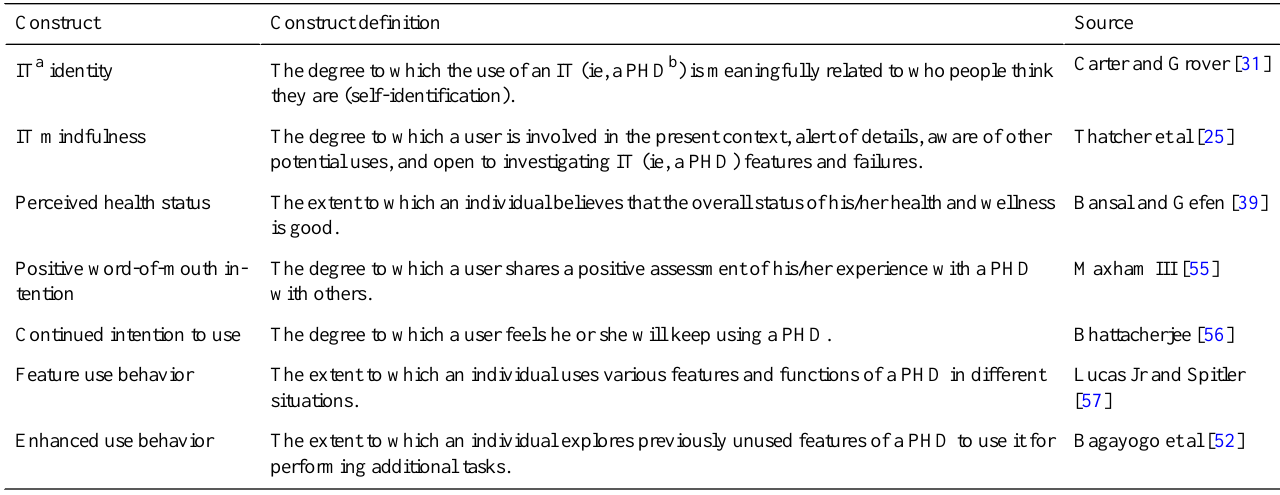
Table 1. Operationalization of variables.